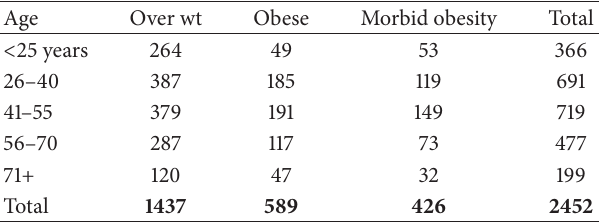
Table 1: Distribution of the study population by diabetes and age.